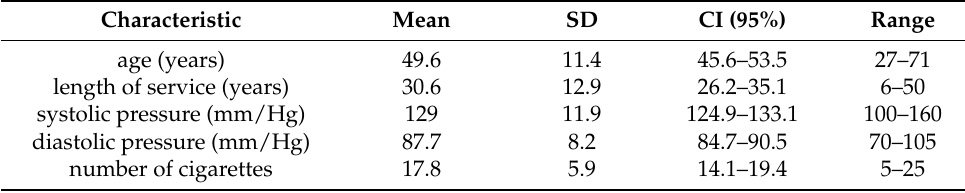
Table 1. Descriptive characteristics of fishermen investigated in this